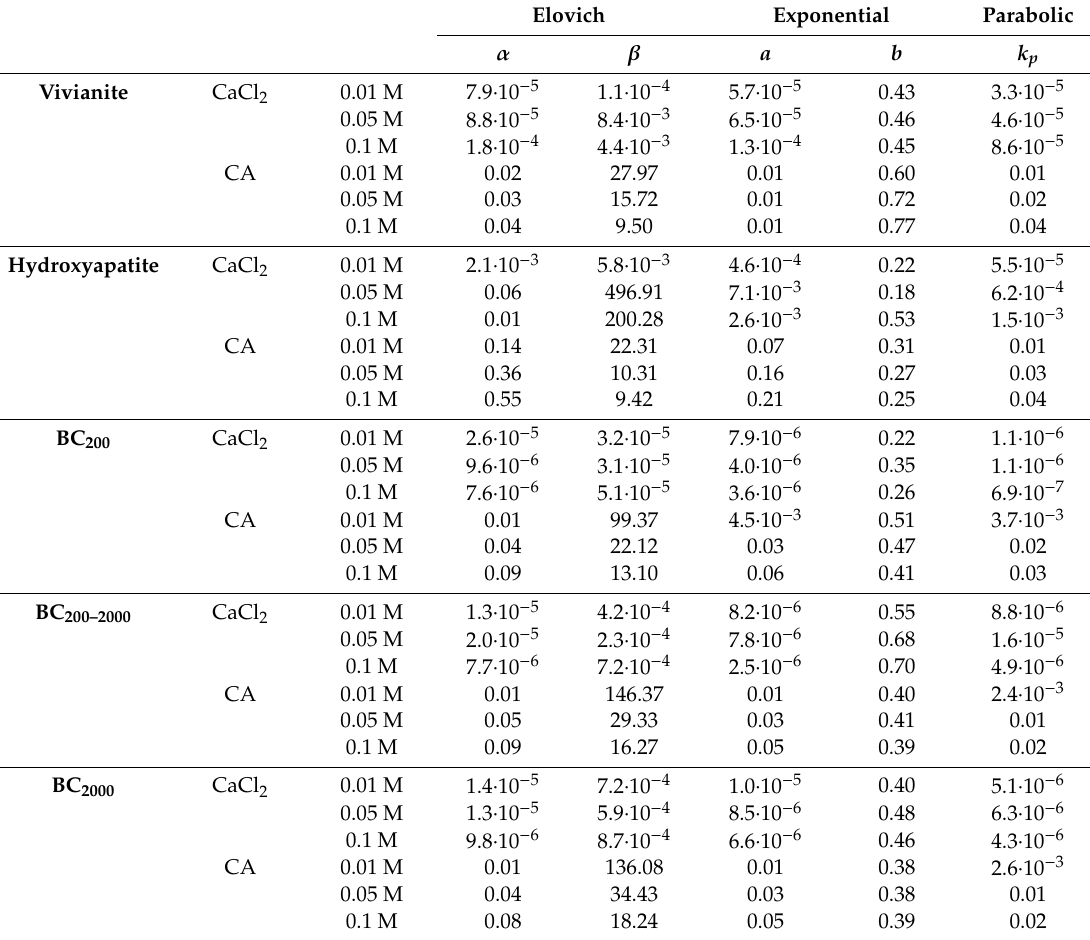
Table 5. Kinetic parameters of the Elovich, Exponential, and Parabolic function